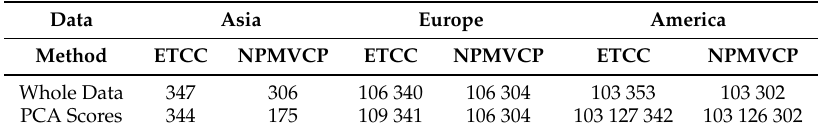
Table 14. Change point detection by ETCC and NPMVCP with real exchange currency data (1/3/2013 to 10/6/2014).